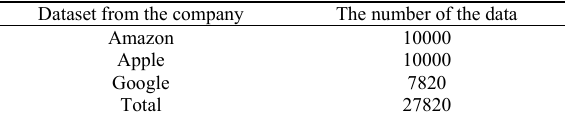
TABLE 1 T HE N UMBER OF D ATASET FROM E ACH C OMPANY Dataset from the